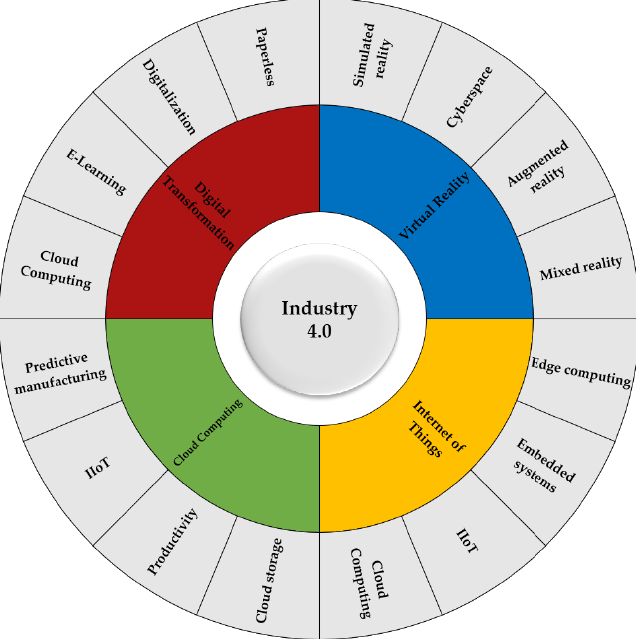
Figure 1. Sunburst and interconnection of Industry 4.0 components. IIoT: Industrial Internet of Things.